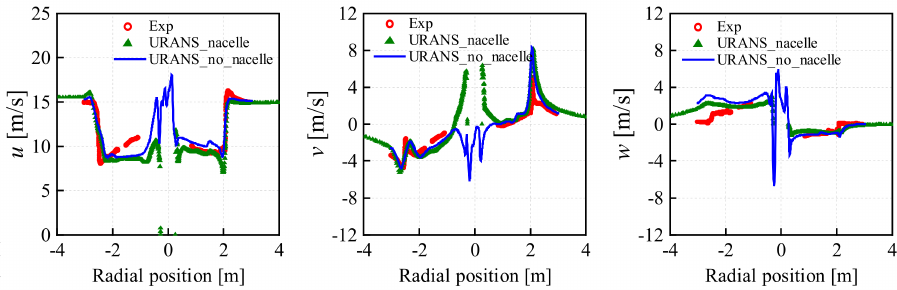
Figure 10. Comparisons of radial velocity distributions at x = 0.3 m regarding nacelle effect.